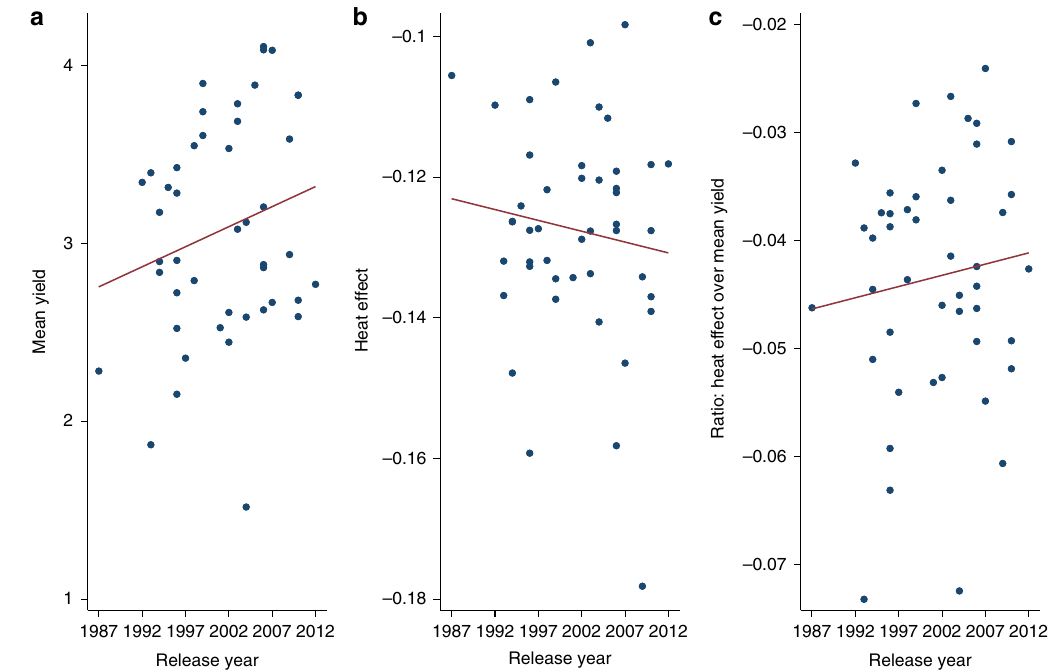
Fig. 5 Mean yields and the effect of heat across wheat cultivar release years. The fi gure shows the tradeoff between mean yields and the effect of temperature occurrences above 30 °C (heat effect) across cultivars based on the year they were commercially released. Data points are for speci fi c cultivars and lines are linear trends. Panels a , b , and c report values for mean yields, heat effects, and the heat effect normalized by mean yield, respectively.